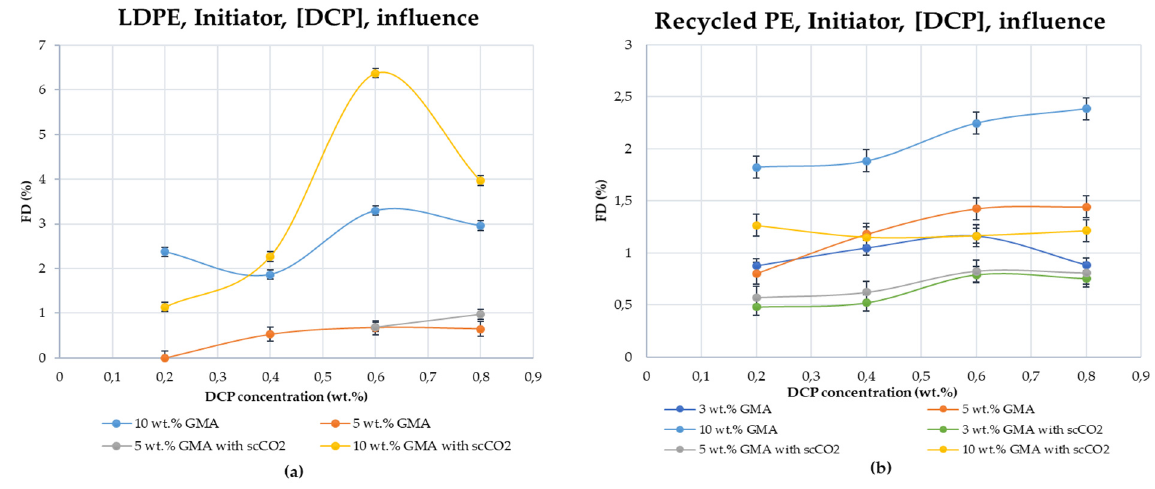
Figure 3. Effect of initiator concentration on the FD for LDPE ( a ) and RPE ( b ).